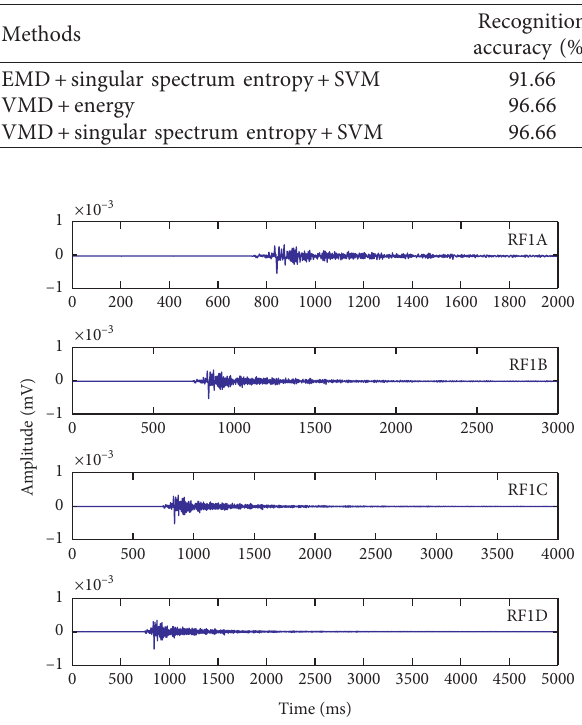
Figure 5: Different numbers of sampling points for the micro- seismic signals.